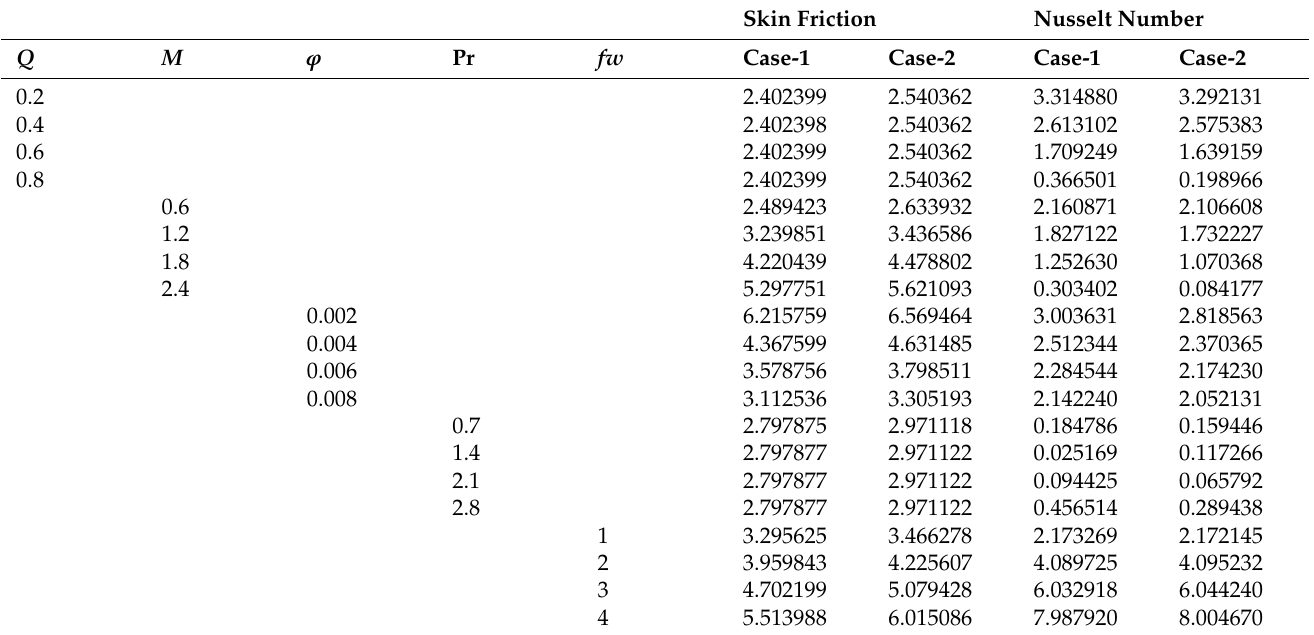
Table 2. The values of the skin friction coefficient and the local Nusselt number as a physical parameter. Skin Friction Nusselt